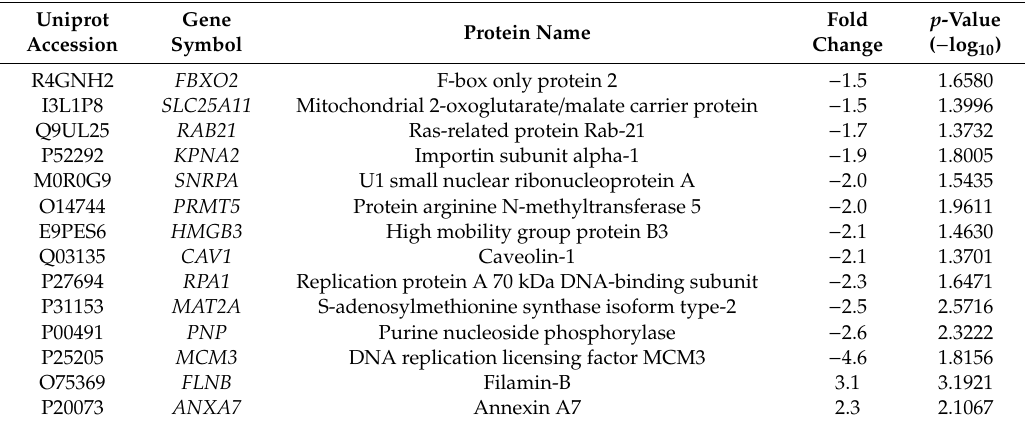
Table 1. Proteins dysregulated by guggulsterone treatment in HCT 116 cells identified by label-free shotgun proteomics